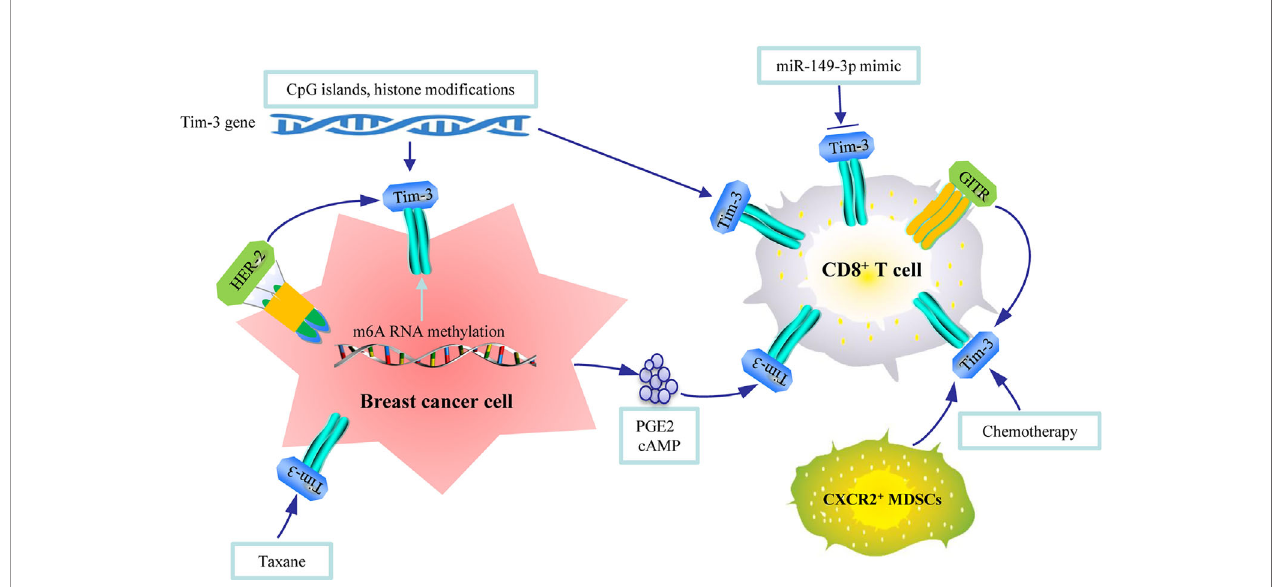
FIGURE 2 | An illustration of the regulation mechanisms of Tim-3 in breast cancer. CpG islands and histone modi fi cations in Tim-3 gene, N6-methyladenosine (m6A) RNA methylation, epidermal growth factor receptor 2 epidermal growth factor receptor 2 (HER2) expression, and taxane can regulate the expression of Tim-3 in breast tumor tissues. Micro RNA, cytokines released by tumor cells, TNF receptor, MDSCs, and chemotherapy can regulate the expression of Tim-3 in immune